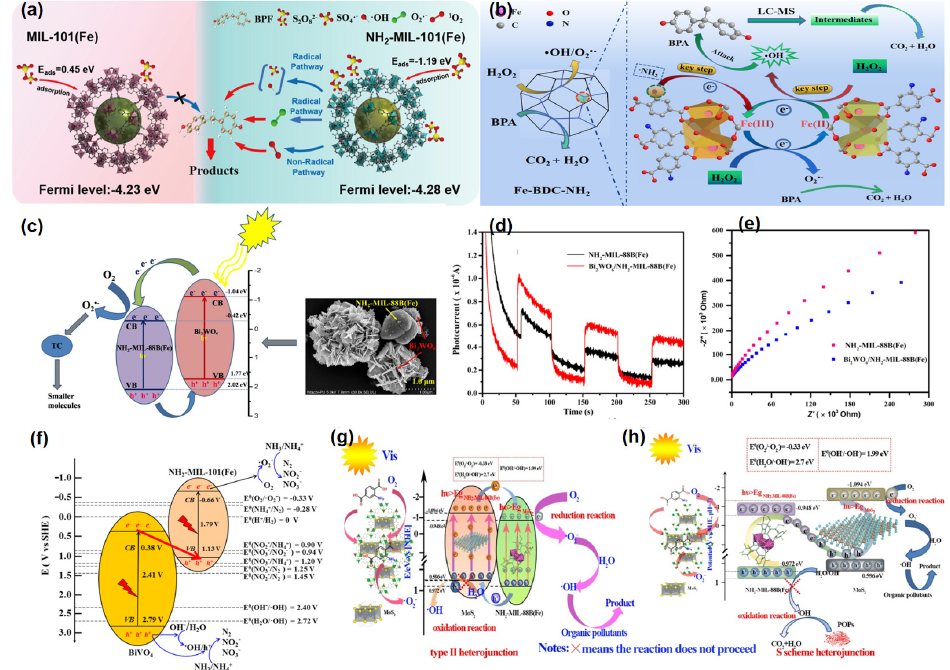
Figure 7. ( a ) Schematic illustration of mechanism of BPF removal in NH 2 -MIL-101(Fe)/PS or MIL-101(Fe)/PS systems [51]; ( b ) Schematic illustration of mechanism of BPA removal in Fe-BDC-NH 2 /H 2 O 2 system [35]; ( c ) Proposed photocatalytic mechanism of Bi 2 WO 6 /NH 2 -MIL-88B(Fe) composite for the degradation of TC [52]; ( d ) Transient photocurrent response [52]; ( e ) EIS spectra of NH 2 -MIL-88B(Fe) and Bi 2 WO 6 /NH 2 -MIL-88B(Fe) [52]; ( f ) Mechanism for ammonia removal [61]; ( g ) type II photocatalytic mechanism for NH 2 -MIL-88B(Fe)/MoS 2 nanocomposite under Xenon lamp irradiation [53]; and ( h ) S-scheme photocatalytic mechanism for NH 2 -MIL-88B(Fe)/MoS 2 nanocomposite under Xenon lamp irradiation [53].